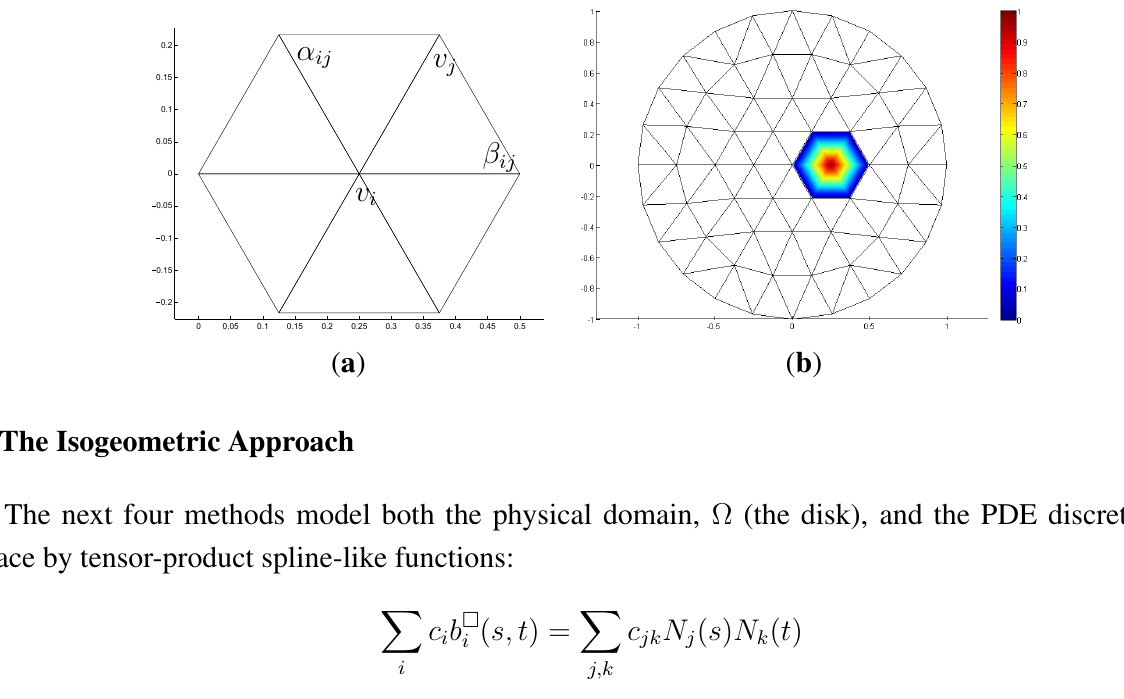
Figure 3. Discrete differential geometry (DDG) notation and linear functions. ( a ) Notation of Equation (2); ( b ) top view of the linear “hat”